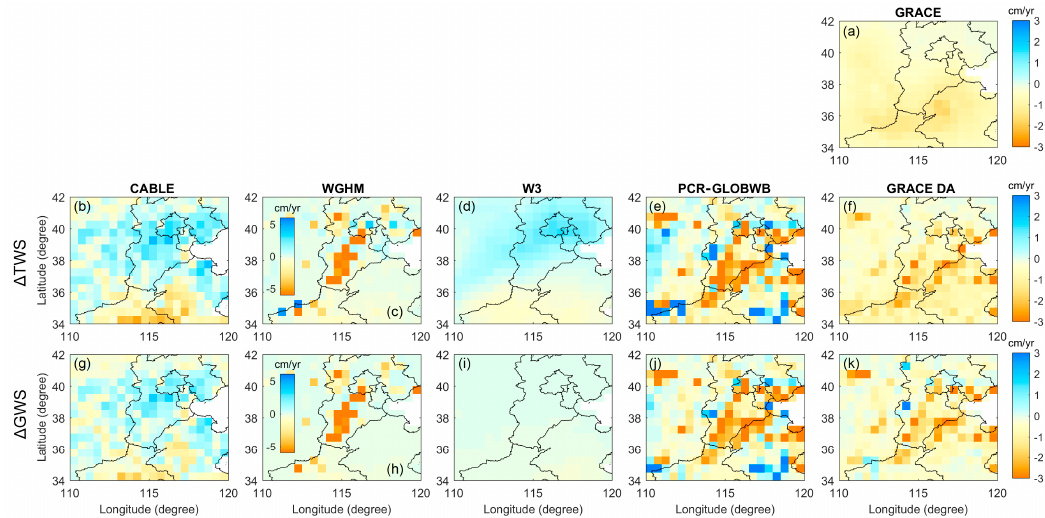
Figure 8. Same as Figure 7, but in the NCP. Note that the color scale of WGHM is different from other models, a more than twice as great (see insert color bars in ( c , h) ).